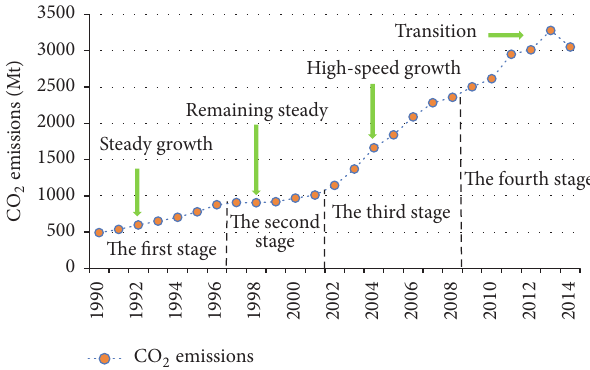
Figure 7: Division of time intervals of CO 2 emission growth in China’s power